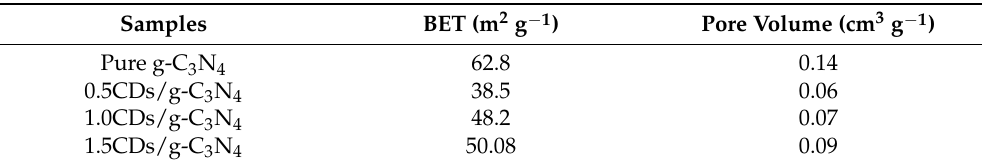
Table 2. Textural properties of the synthesized pure g ‐ C 3 N 4 and CDs/g ‐ C 3 N 4 photocatalysts ob ‐ tained from the N 2 adsorption ‐ desorption analysis.